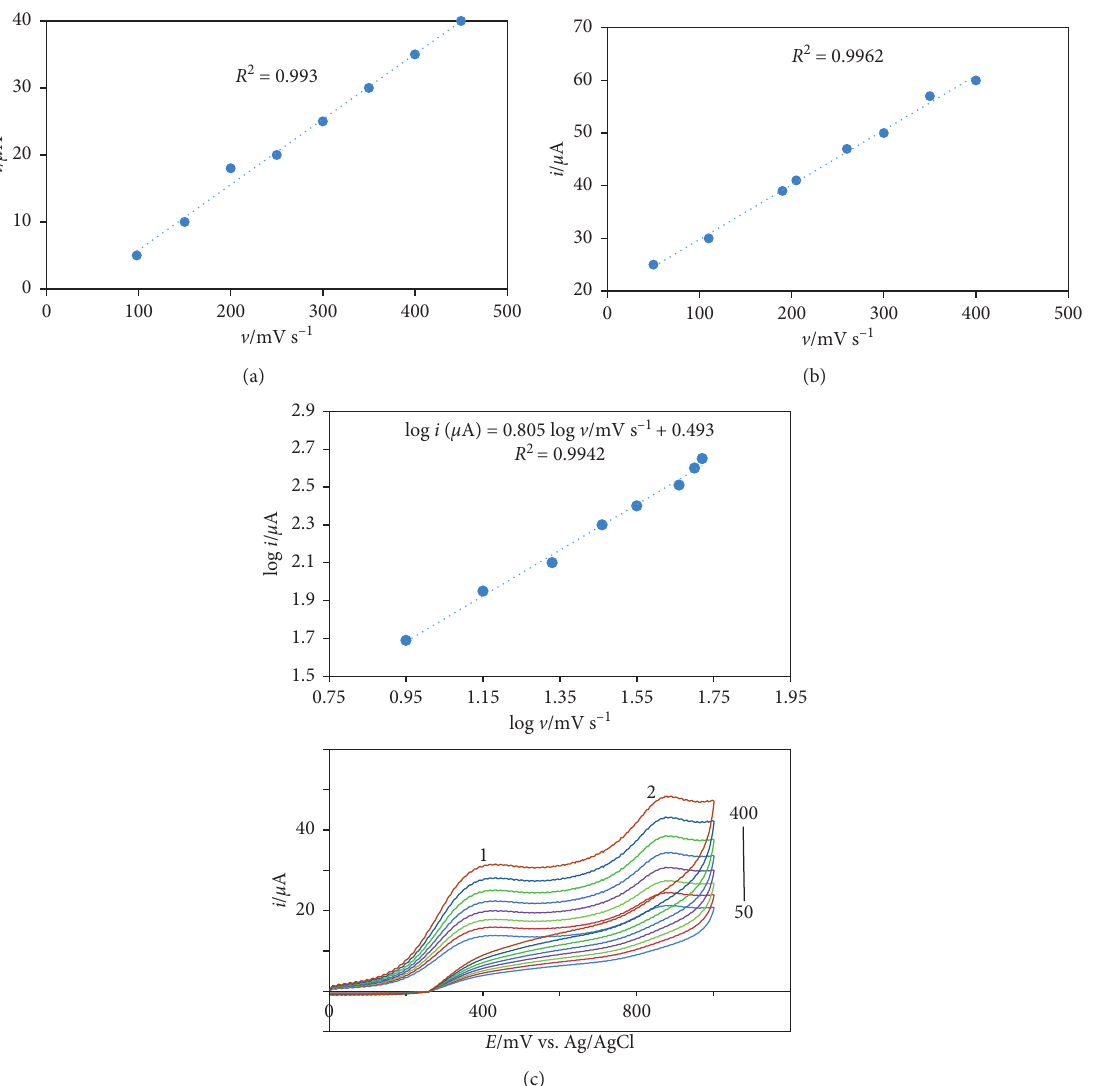
Figure 5: CVs of 0.1mM nevirapine (1) and 0.1mM glucose (2) in 0.1 M PBS (pH 11.0) at TiO (50–400 mV/s). Inset: (a) plot i pa ( μ A) versus v (mV/s); (b) log i pa ( μ A) versus log v (mV/s) (nevirapine); (c) plot i pa ( μ A) versus v (mV/s)